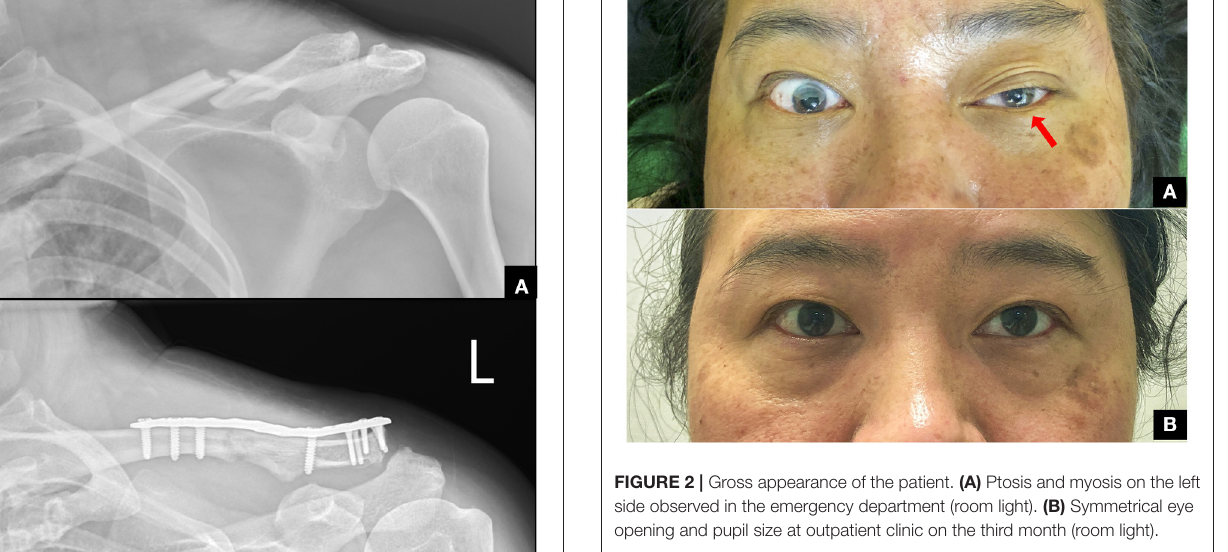
hypothalamus and ends in the intermediolateral horn of